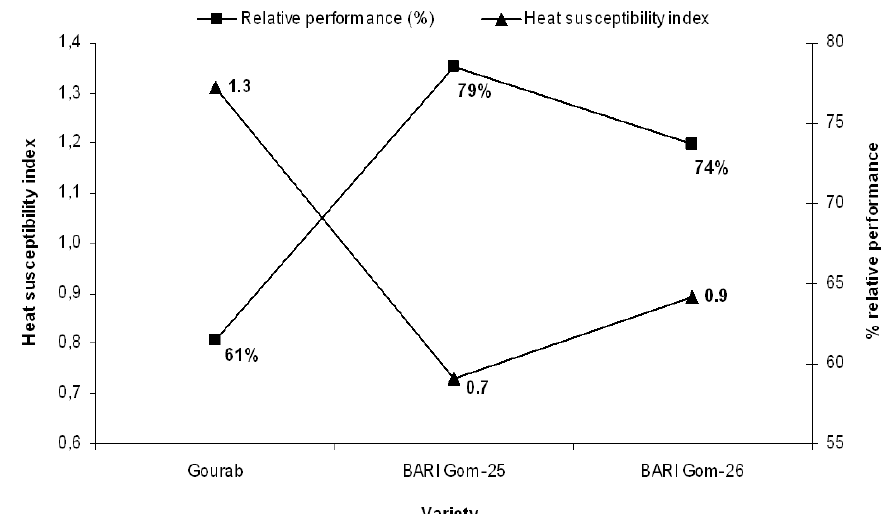
Fig. 11. Relative performance (%) and heat susceptibility index of 3 wheat varieties in very late heat stress condition, as compared with optimum